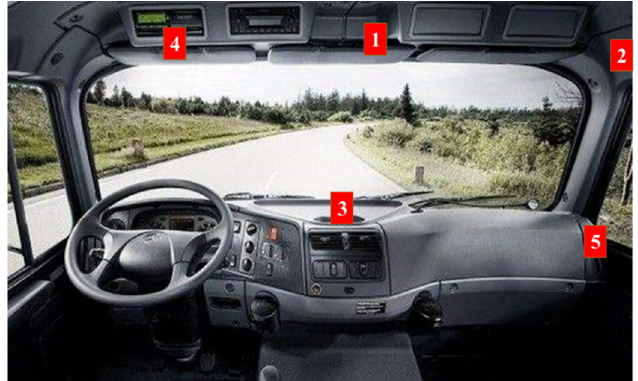
Figure 5. View point selection diagram.